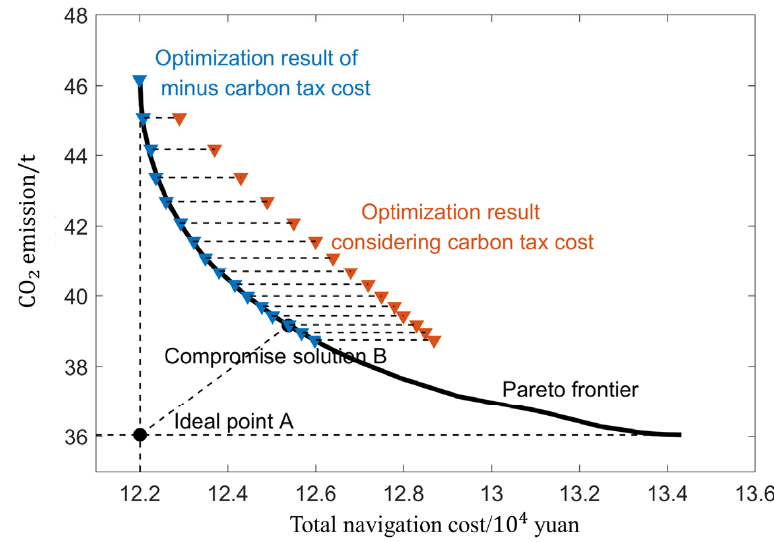
Figure 23. Comparison of optimization results considering carbon tax rates and multi-objective op ‐ timization results.